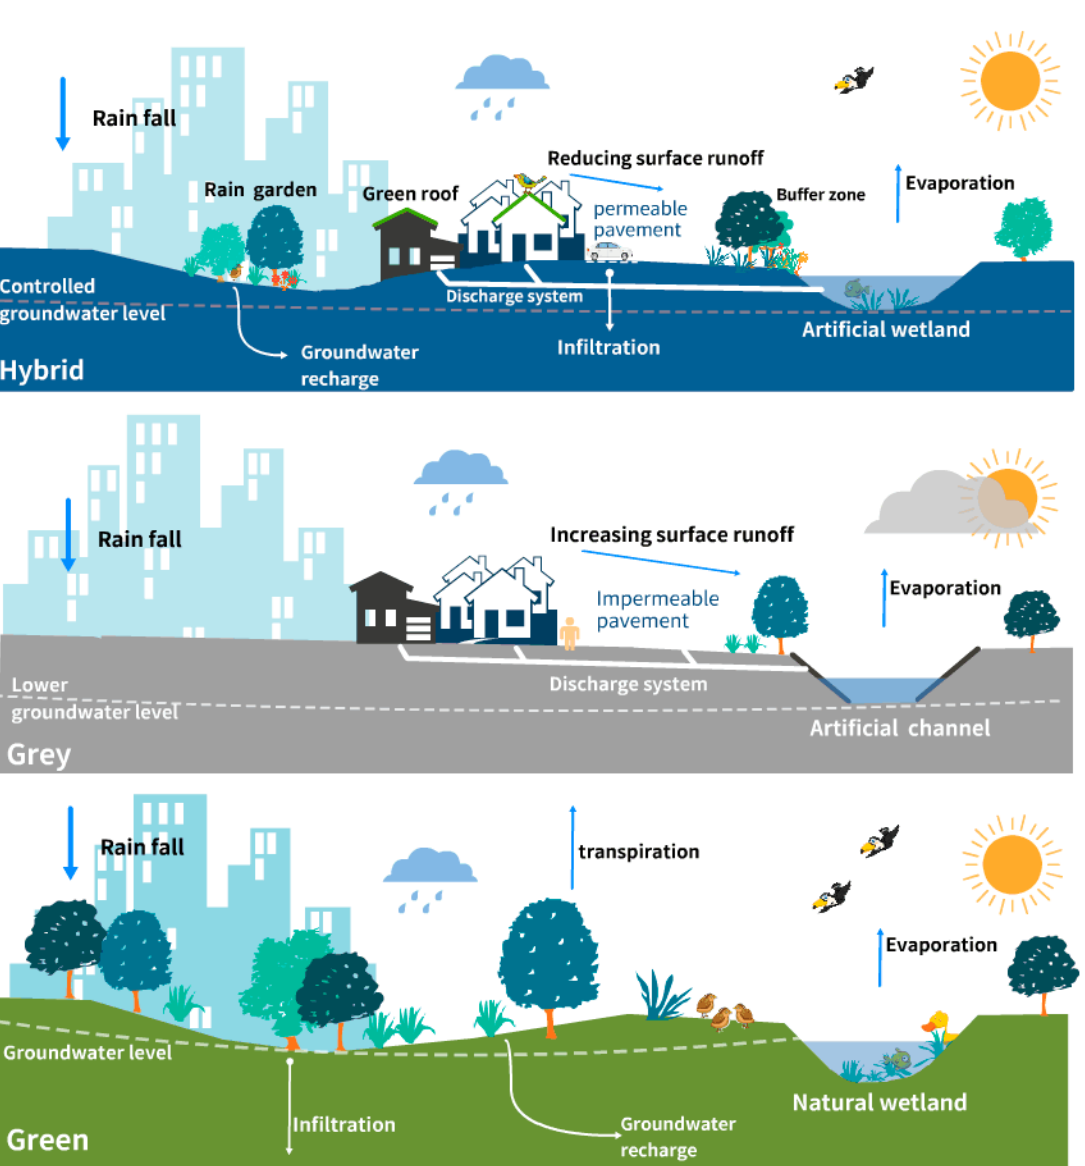
Figure 5. NBS integrates the grey and green to create hybrid approaches. Closely adapted from Source: authors.